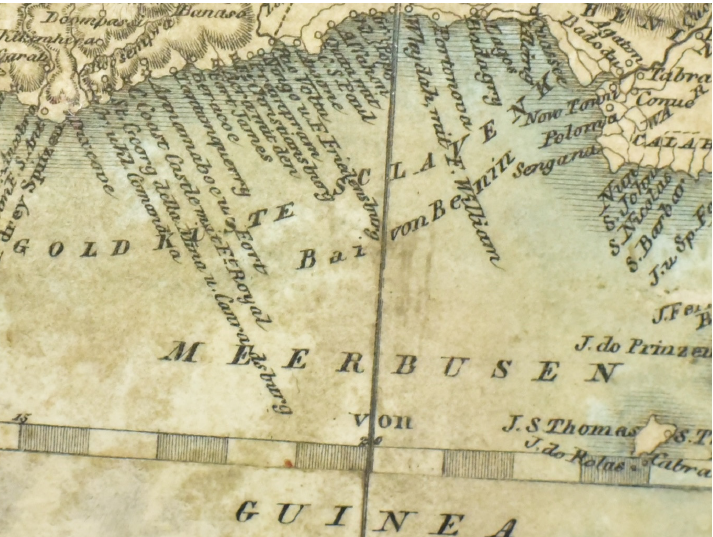
Figure 3. Detail of the researched globe by J. Jüttner. Source: Map Collection of the Faculty of Science, Charles University.